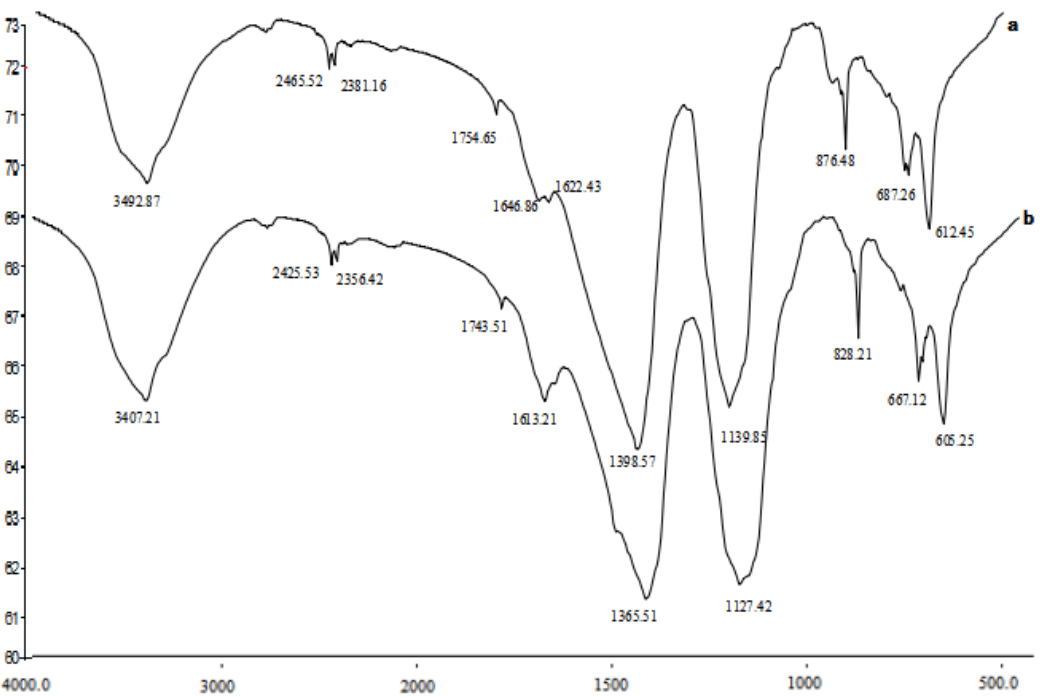
as the mean ± SD ( n = 3).